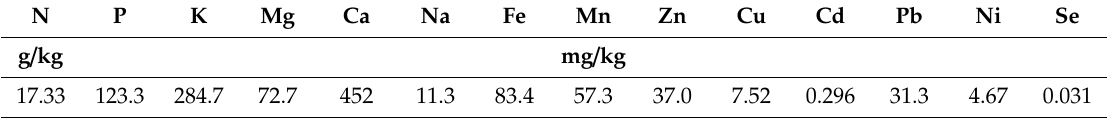
Table 7. Mineral composition of soil in which the two goji cultivars grew in orchard. N P K Mg Ca Na Fe Mn Zn Cu Cd Pb Ni Se g / kg mg / kg